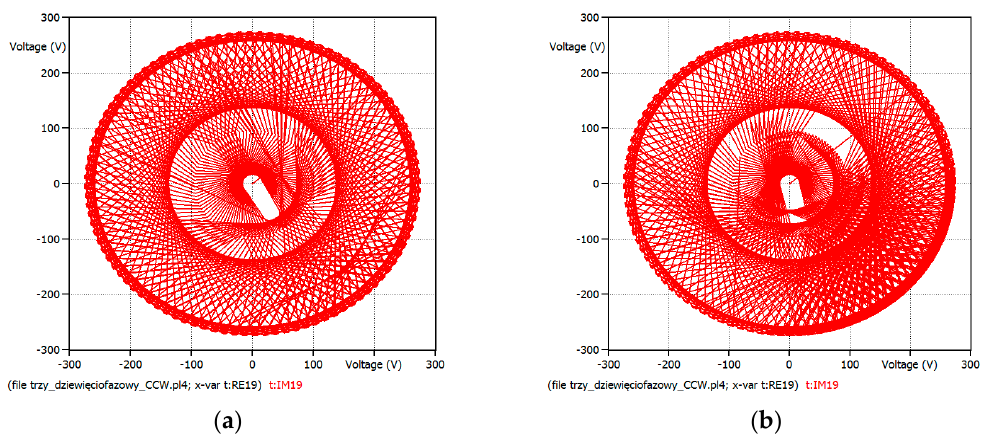
Figure 13. Trajectory of the output rotating voltage space vector for the voltage transfer ratio: ( a ) k U = 0.1 and ( b ) k U = 0.5. Simulations performed for the output frequency f o = 30 Hz, for one period of output frequency and CCW method.